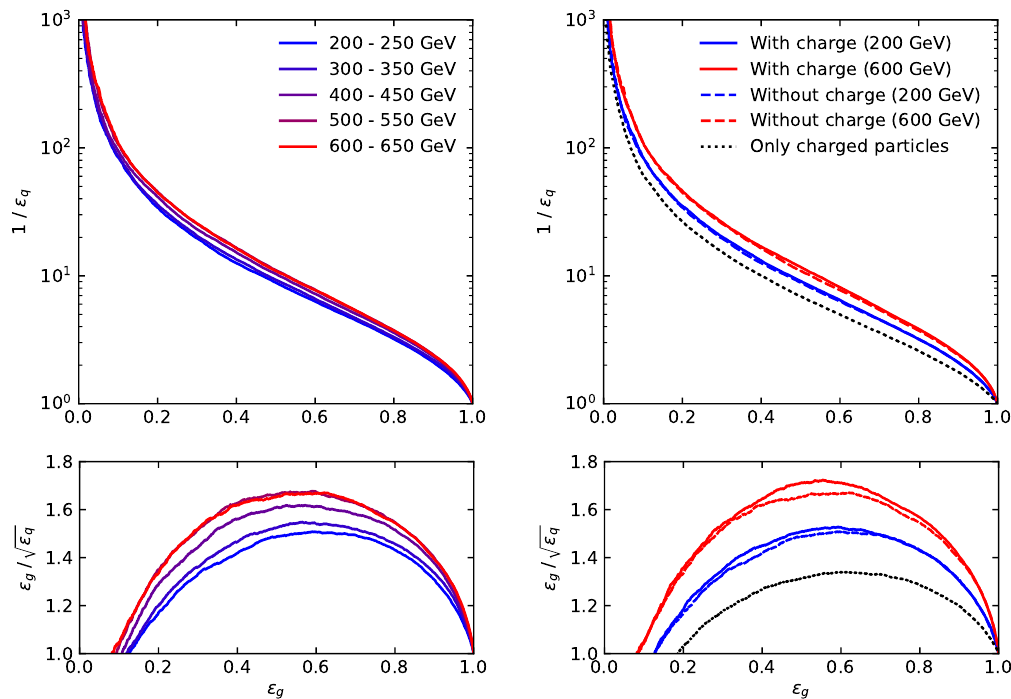
Figure 6: Left: ROC and SI curves for the pure quark and gluon samples in non- overlapping jet p ranges. Right: ROC and SI curves for the pure quark gluon samples T including charge